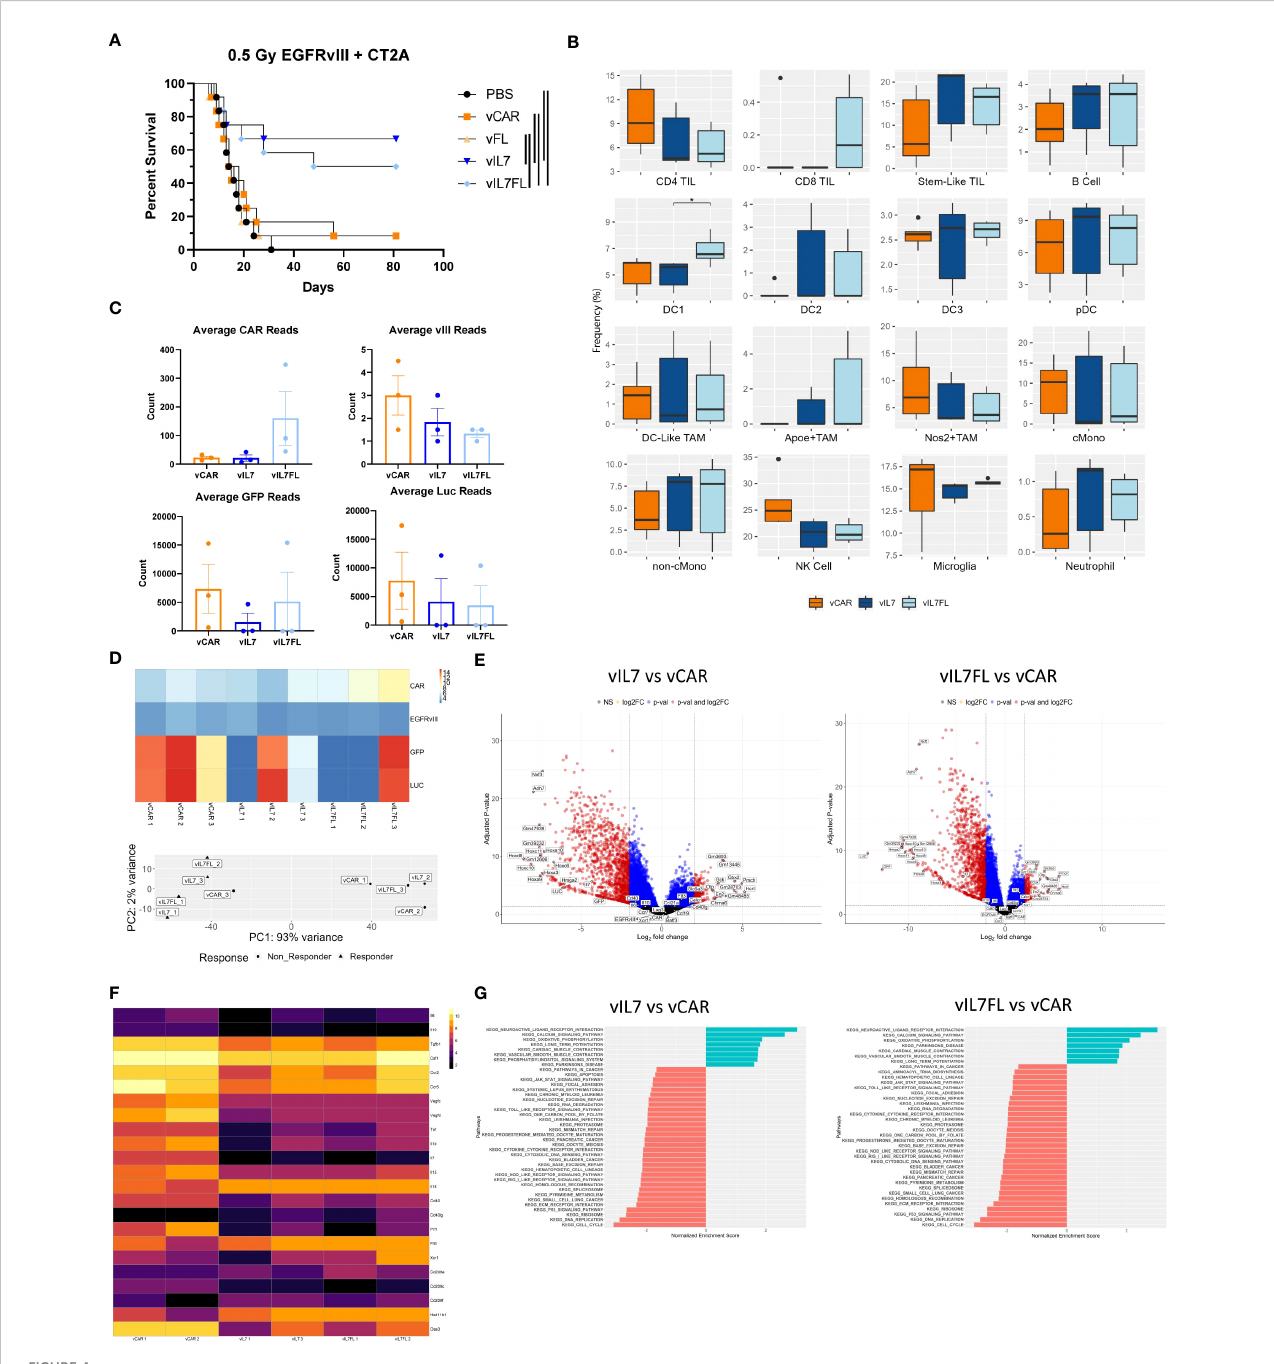
FIGURE 4 IL7 and IL7 Flt3L co-expressing CAR T cells increased survival in a 0.5 Gy TBI EGFRvIII heterogeneous model. Animals were inoculated with 50% vIII and 2A tumor cells and IVIS imaged 5 days later. (A) On day 6, 0.5 Gy TBI was applied and 2x10^6 CAR T cells were injected intracranially on day 7 and overall survival was assessed (n=12). Kaplan-Meier survival curves represent a combination of two independent experiments. Signi fi cance is noted with the log-rank Mantel-Cox test. (B) 7 days after tumor inoculation 0.5 Gy TBI was applied and 2x10^6 CAR T cells were injected intracranially on day 7. One week post CAR T cell injection, the tumor-bearing hemisphere was isolated for bulk RNA sequencing (n=3). (C) Transgene counts were found by averaging the lane reads in each sample. (D) Transgene heatmap using normalized data and principal component analysis. (E) Volcano plots with thresholds of log2 fold change = 2 and adjusted p-value = 0.05. (F) Normalized heatmap of selected differentially expressed genes. (G) KEGG analysis using non-adjusted p-value < 0.05 with an adjusted p-value of < 0.1 Differential expression between transgenes and all other genes was found using alternative shrink estimator ashr with a Benjamini-Hochberg correction with a FDR <